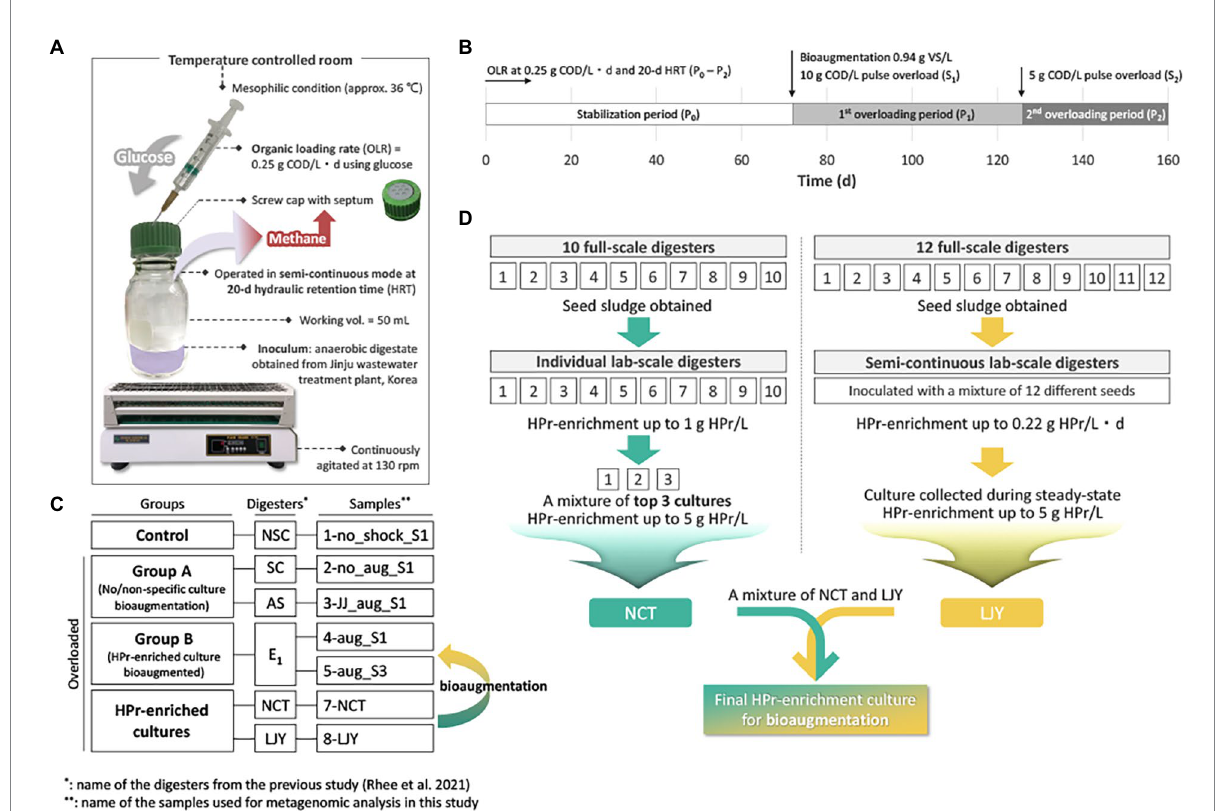
FIGURE 1 (A) The exprimental setup for the semi-continuous AD bioreactor tests. (B) Overview of the experimental timeline. Detailed methods for the AD operation can be found in (Rhee et al., 2021b). OLR, organic loading rate; COD, chemical oxygen demand; VS, volatile solids; HRT, hydraulic retention time. (C) Overview of the sample information. Please see the methods and Table 2 for the details. (D) Strategy of two HPr-enrichment cultures preparation and detailed information can be found in (Kim et al., 2015; Jannat et al., 2021; Lee et al.,